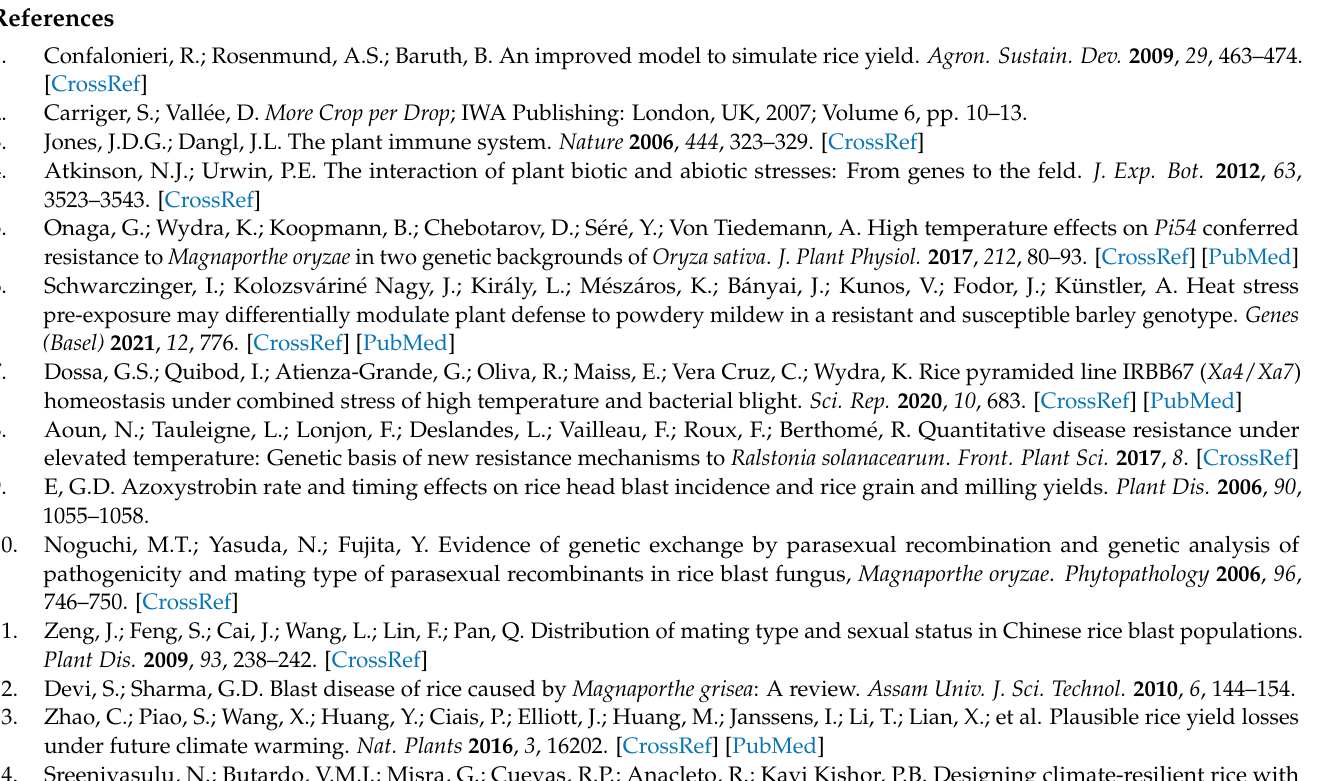
ping in rice, Table S2: Significant information of 32 previous studies related to heat-tolerance QTL mapping, Table S3: Interval genes in 67 blast-resistant meta-QTLs, Table S4. Interval genes in 40 heat- tolerant meta-QTLs, Table S5: Commen genes from blast-resistant meta-QTLs and heat-tolerant meta-QTLs, Table S6: Differently expressed genes (Gene ID converted from MSU to RAP type) in CO under 35 ◦ C and blast stresses, Table S7: Differently expressed genes (Gene ID converted from MSU to RAP type) from LT under 35 ◦ C and blast stresses, Table S8: Commen genes from meta-QTLs and DEGs in rice, Table S9: Genes in the top 5 enrichenment GO terms, Table S10: Significant information of 55 genes in the top 5 enrichment GO